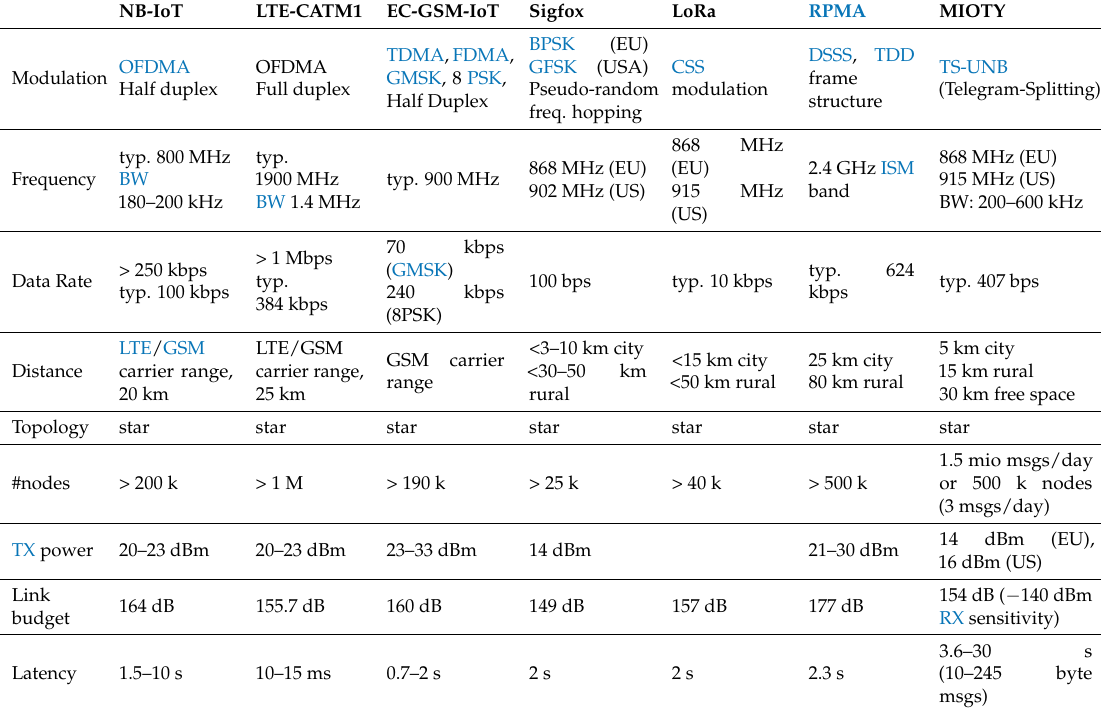
Table 3. Current terrestrial IoT